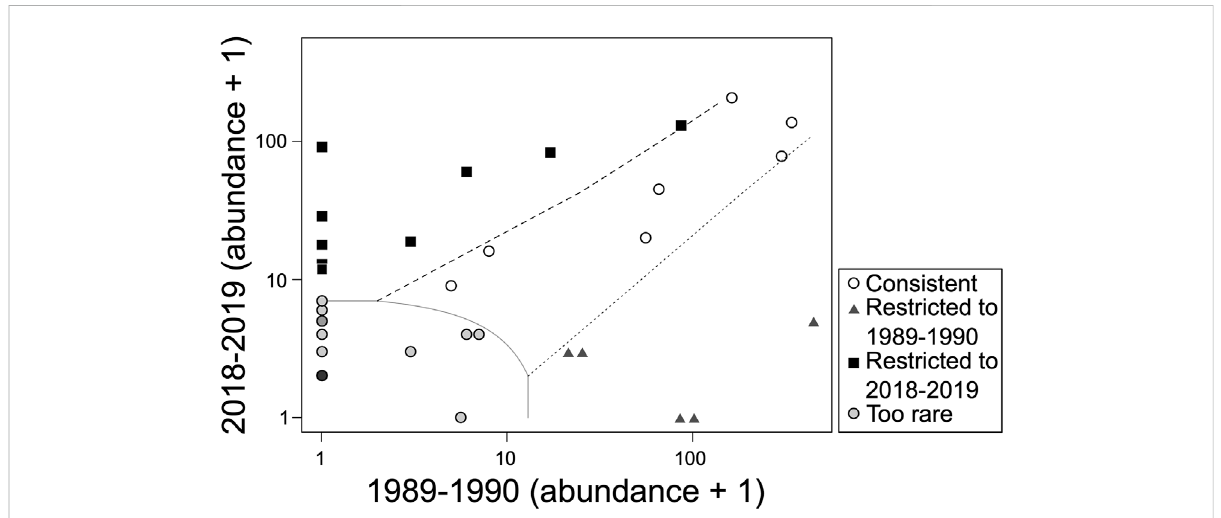
FIGURE 4 Classi fi cation of the 34 fi sh species according to their occurrence in the 1989 – 1990 and 2018 – 2019 surveys using CLAM analysis: Consistent (open circles); species too rare to be assigned to a speci fi c period (grey circles); Restricted to 1989 – 1990 survey (grey triangles) and Restricted to 2018 – 2019 survey (black